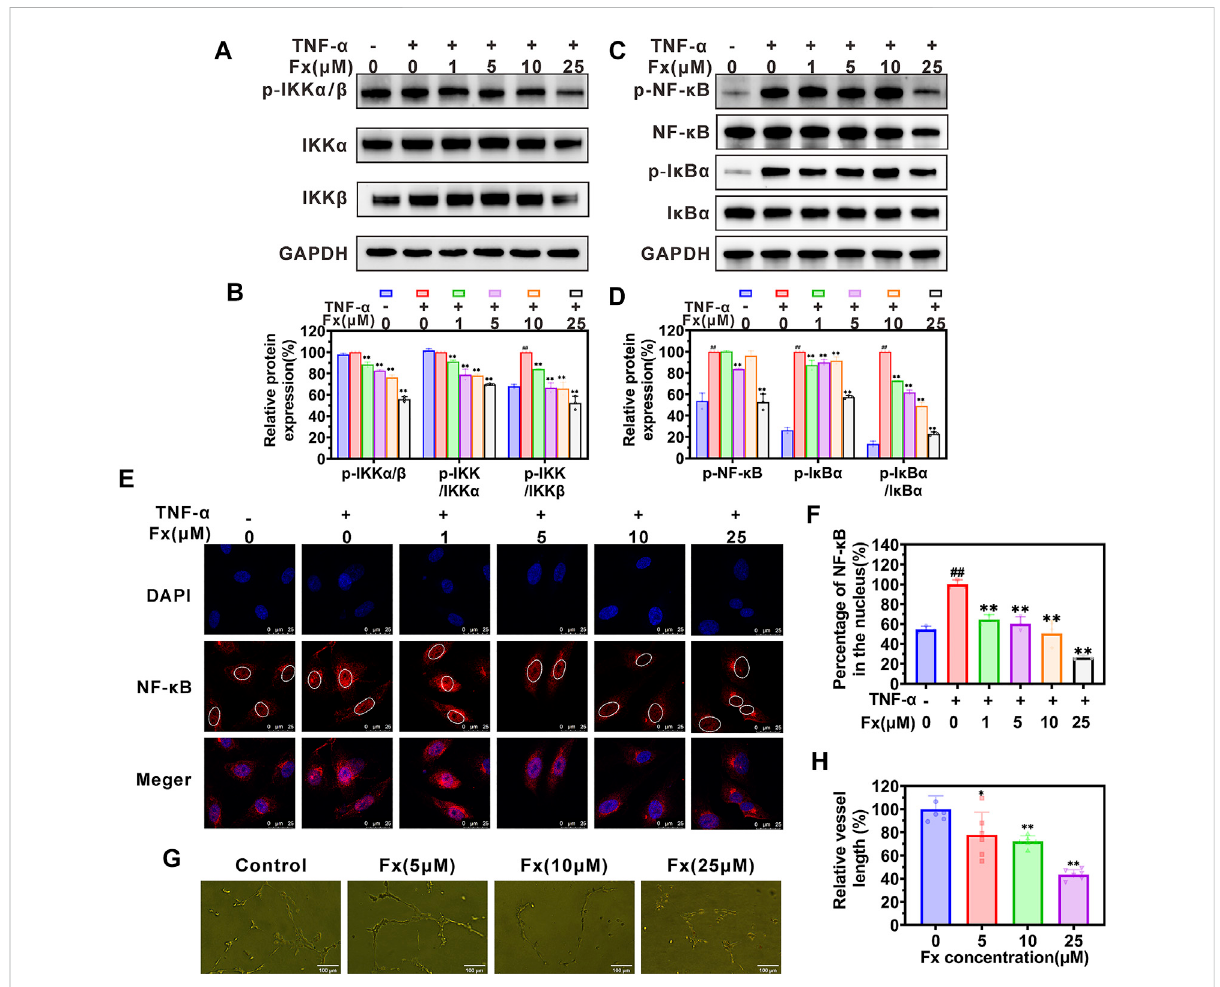
FIGURE 3 Fx inhibits the NF- κ B pathway and capillary tube formation in HUVECs. (A – D) HUVECs were pretreated with Fx (0 μ M, 1 μ M, 5 μ M, 10 μ M and 25 μ M)for24 handthenstimulatedwiththeTNF- α (10 ng/ml)foranother4 h.TheexpressionlevelsofI l B α ,p-I l B α (Ser32),IKK α ,IKK β ,p-IKK α / β